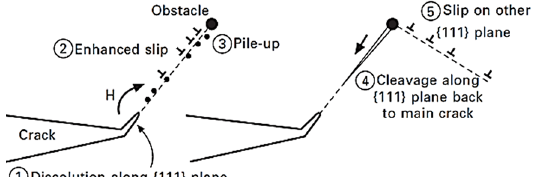
Figure 4. SCC mechanism in FCC metals: hydrogen induced plasticity, promoting denser dislocation pile-up and higher stress field, causing the nucleation and brittle propagation of secondary cracks from the obstacle towards the tip of the primary crack. The stress field will also activate the slip system of the adjacent grain, repeating the process of nucleation and brittle propagation of secondary cracks 4